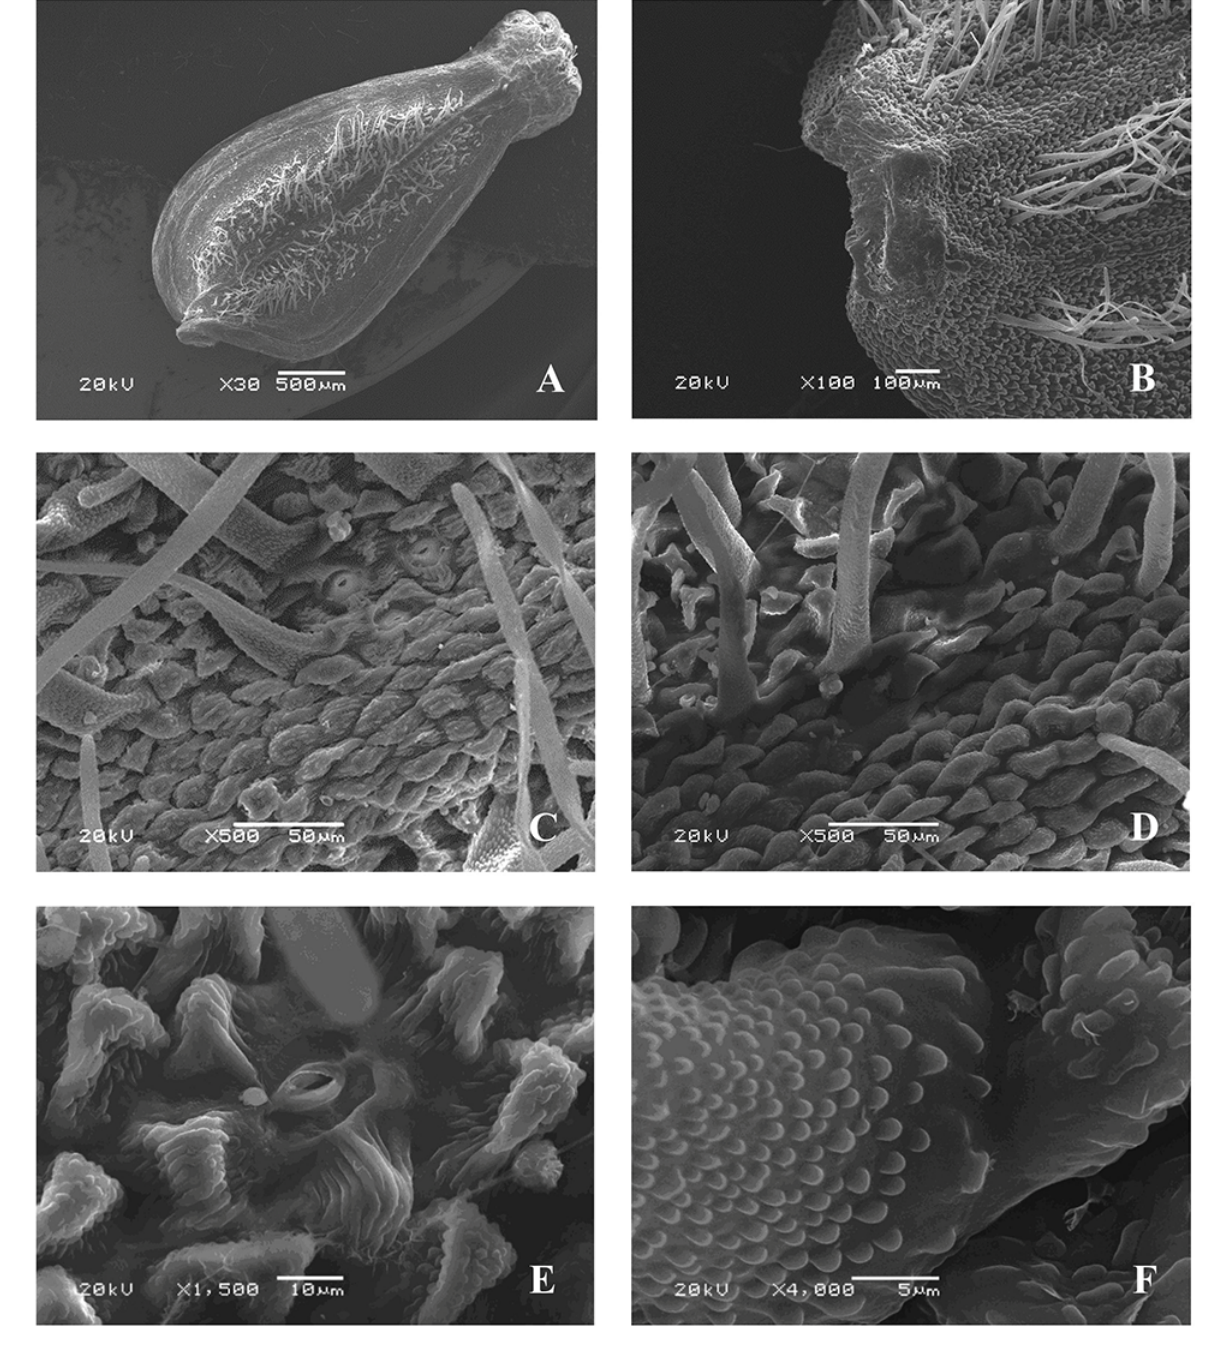
Figure 1 Fruit of Valeriana tuberosa (SEM): General view ( A ); fragments of the fruit surface ( B–D ); stomium ( E ); fragment of the hair surface ( F